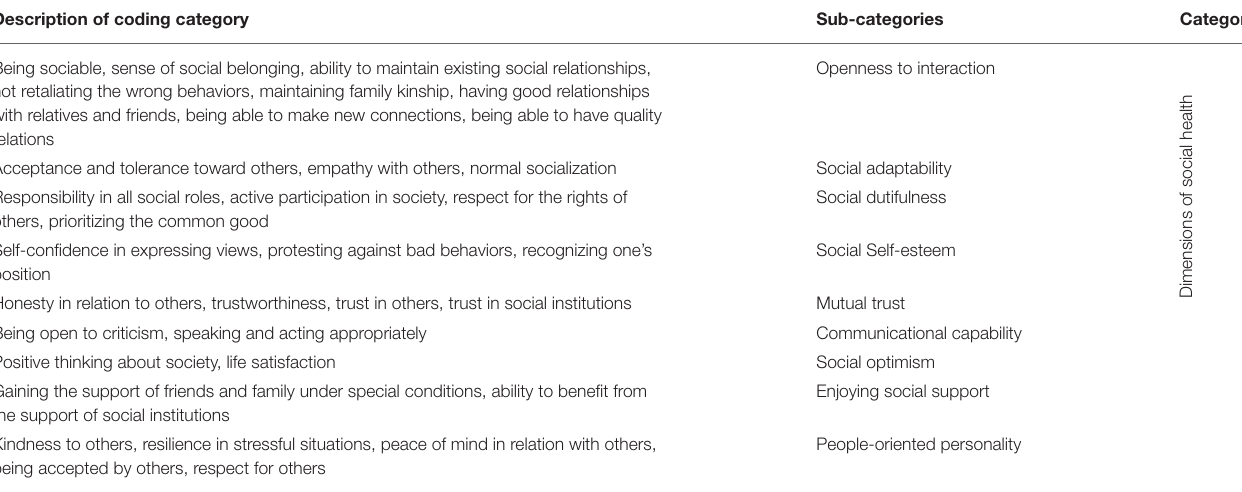
TABLE 5 | Categories, sub-categories and codes obtained from interviews with participants. Description of coding